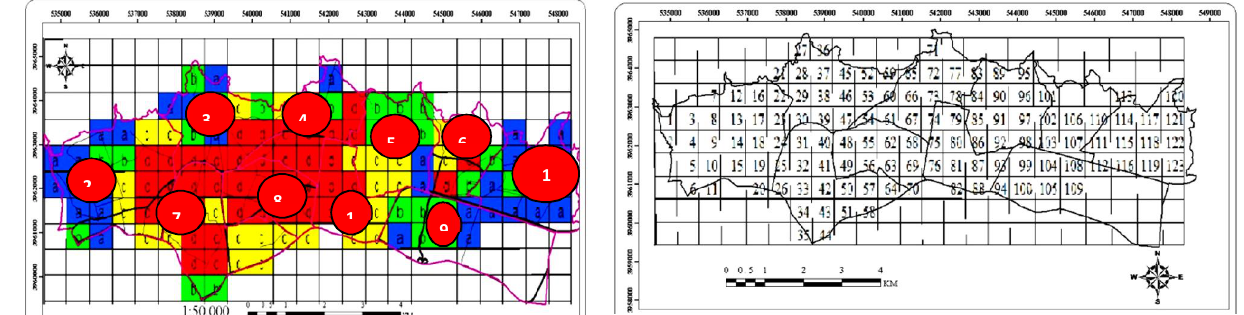
Fig.4. Damage estimation output for the urban district and its municipal wards